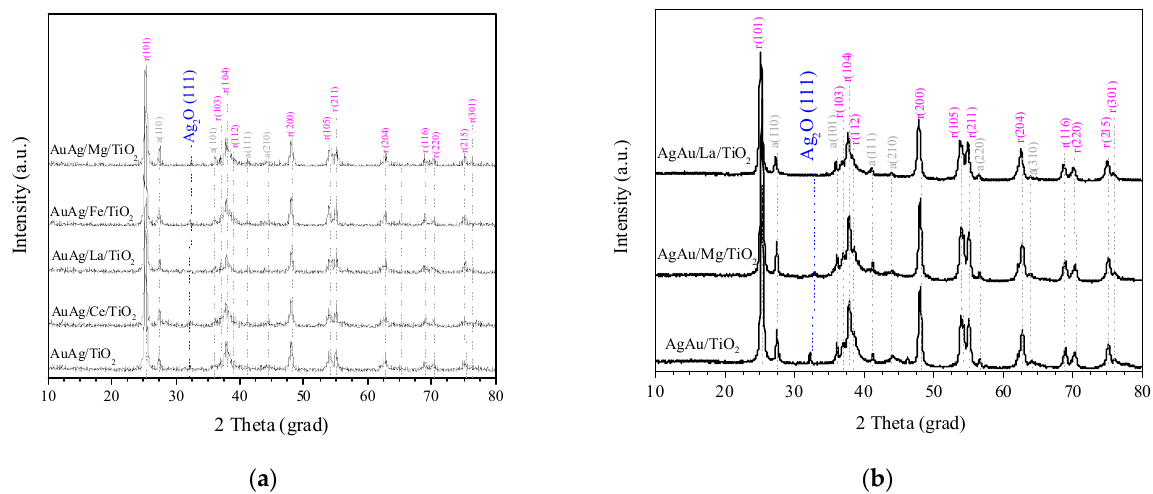
Figure 1. XRD patterns of AuAg ( a ) and AgAu ( b ) catalysts. Diffraction lines corresponding to TiO 2 anatase phase are marked with “a” (in gray color), while those corresponding to rutile have “r” (magenta color) with their corresponding Miller indexes. Samples were studied after a reduction in H 2 at 300 °C for 1 h.